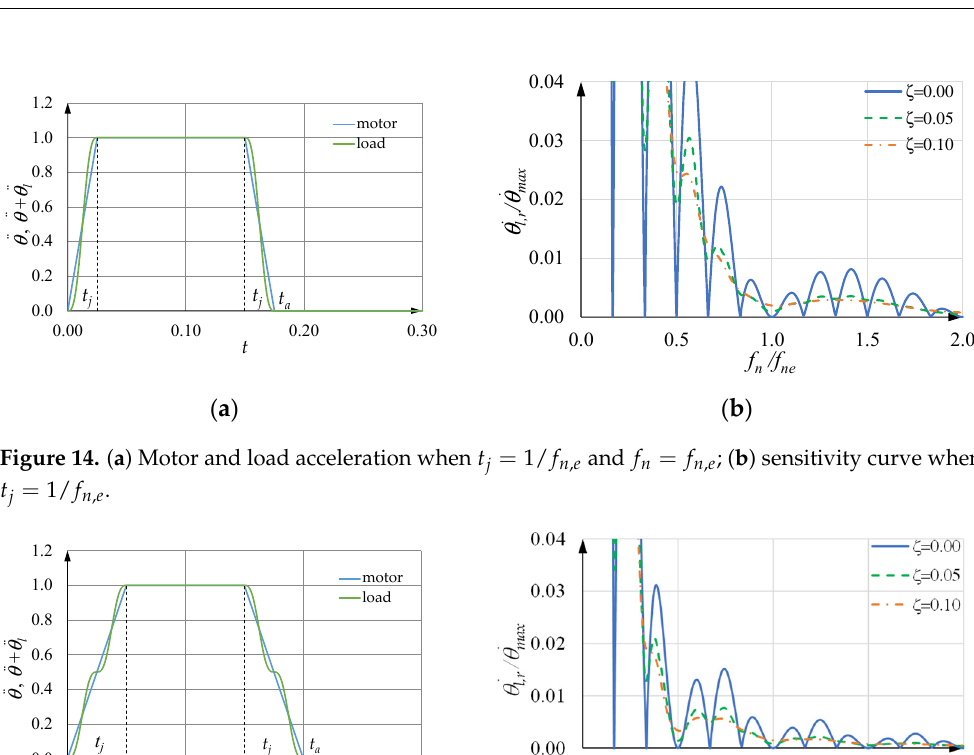
= 3/ f n , e and f n = f n , e ; ( b ) sensitivity curve when j